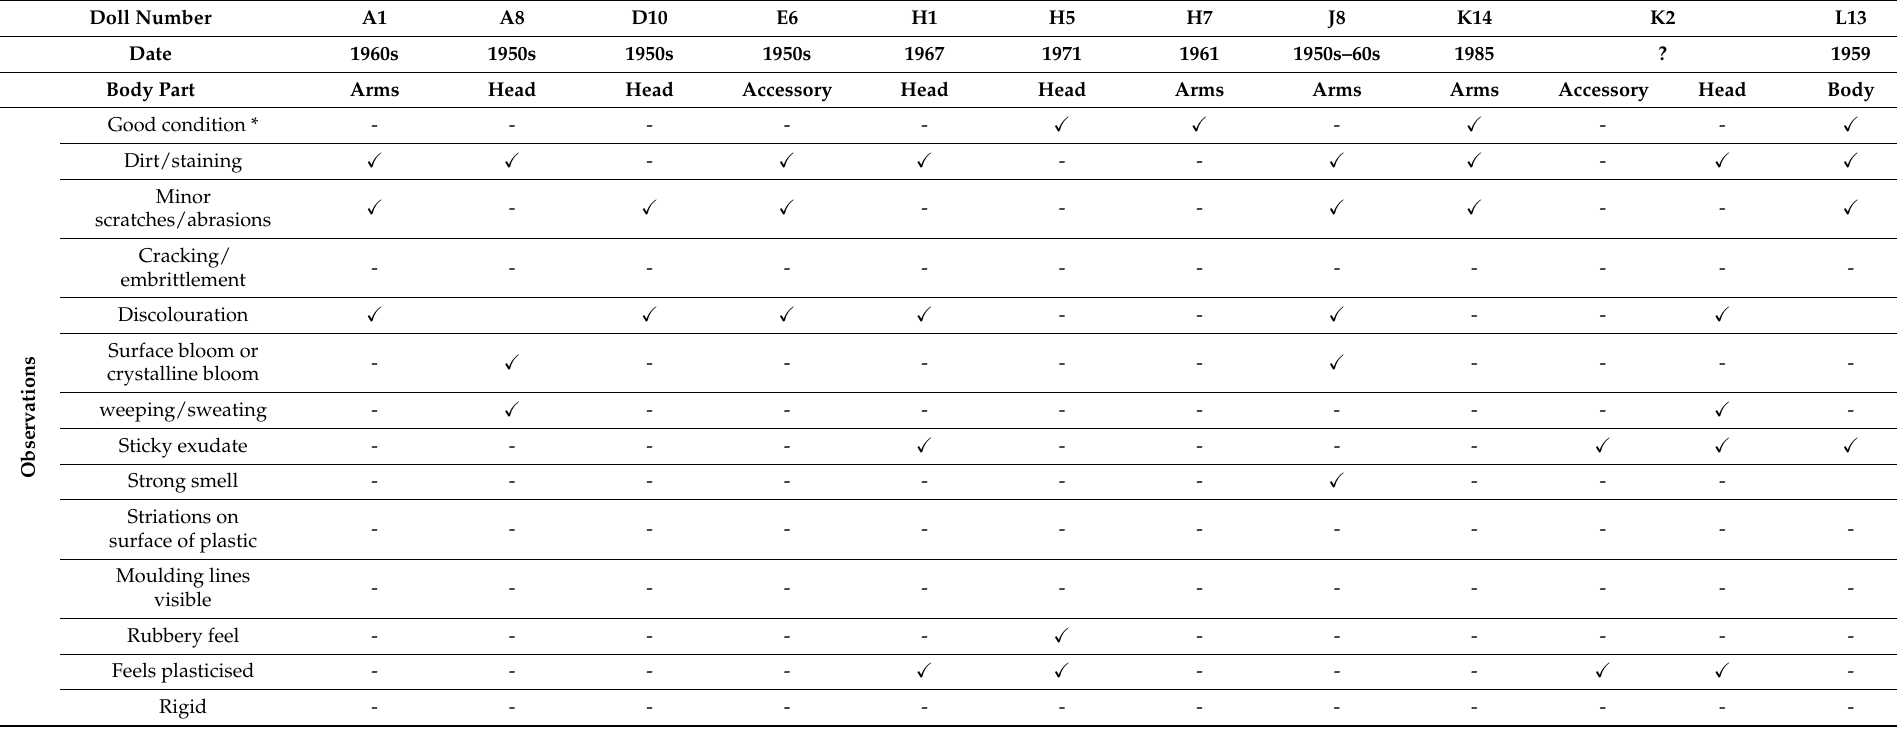
Table 5. Summary of condition of the dolls identified as having PVC components. Dolls with additional CA components are